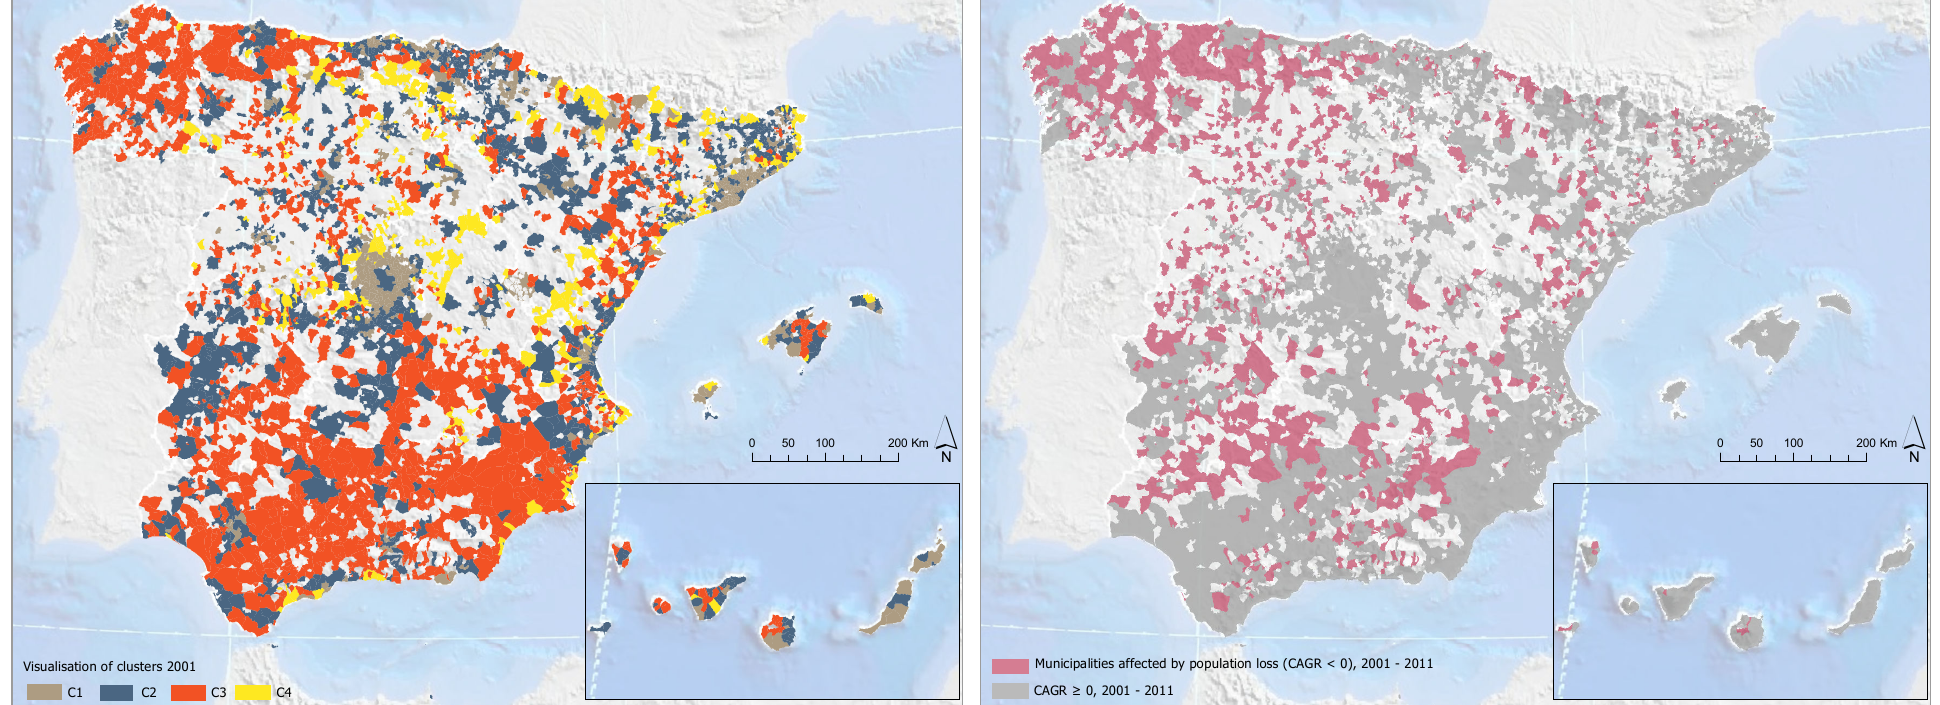
Figure A2. Maps showing the clusters of municipalities from a geographical perspective (part